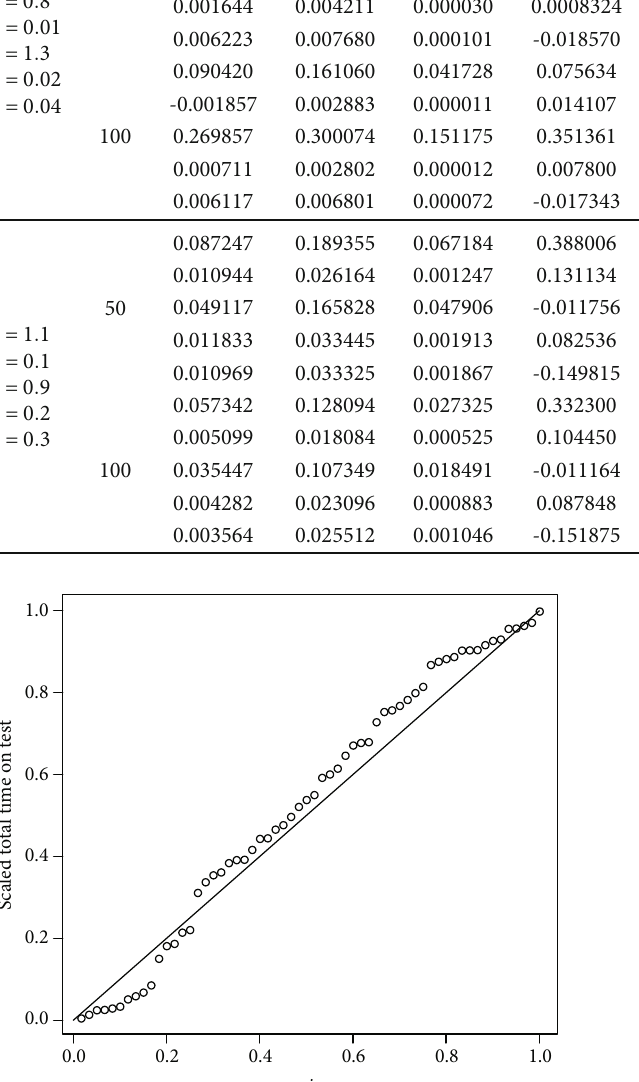
Figure 1: The scaled TTT transform plot for data sets of Table 2.